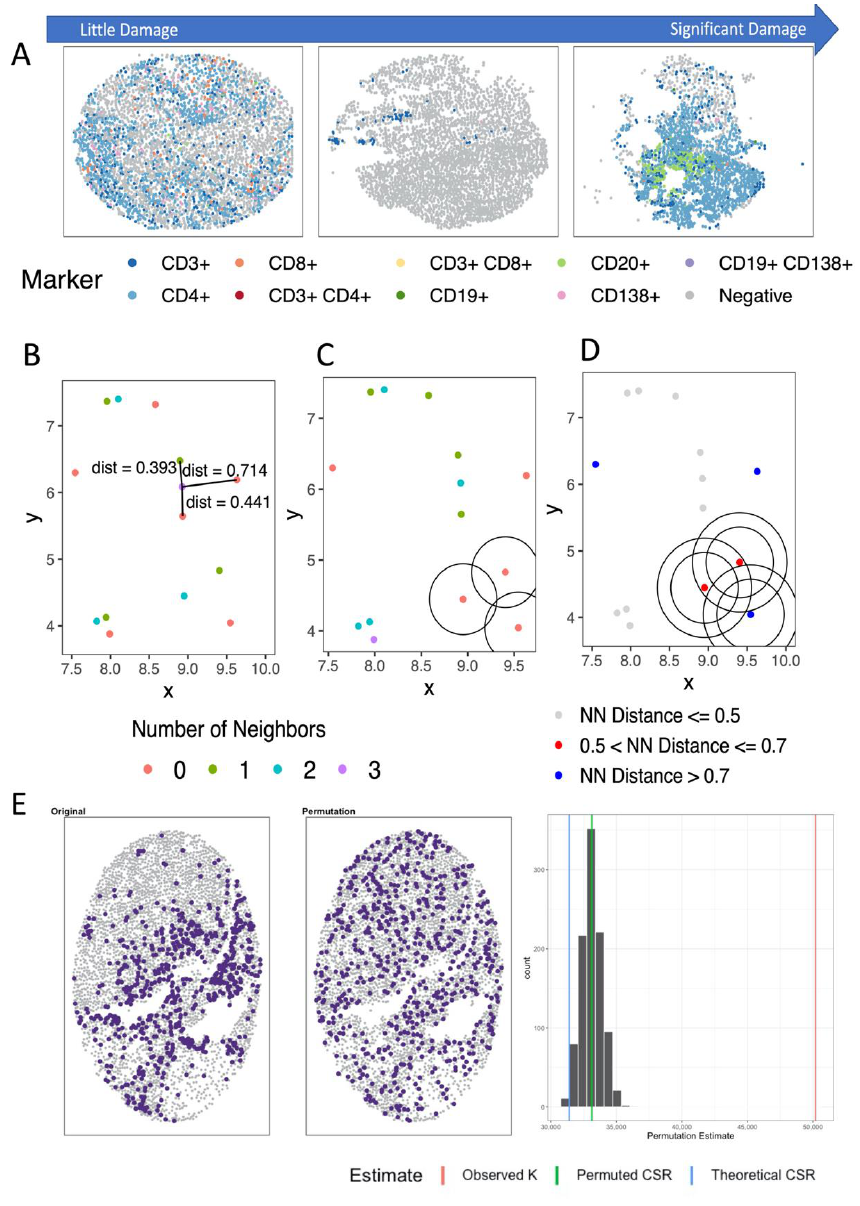
Figure 4. ( A ) Example images showing cores with little to significant damage. A point process generated from simulated data illustrating different approaches for spatial analysis: ( B ) Distance- or nearest neighbor-based methods, ( C ) neighborhood methods such as K ( r ) , L ( r ) , and M ( r ) ; and ( D ) distance to neighbor measures such as h ( r ) and g ( r ) . ( E ) Example of original (left) and permuted point process (middle) with resulting histogram (right) of permutation-based estimates of K showing difference in theoretical and permuted-based estimates of CSR where the theoretical value under-estimated the value of 𝐾 under CSR.